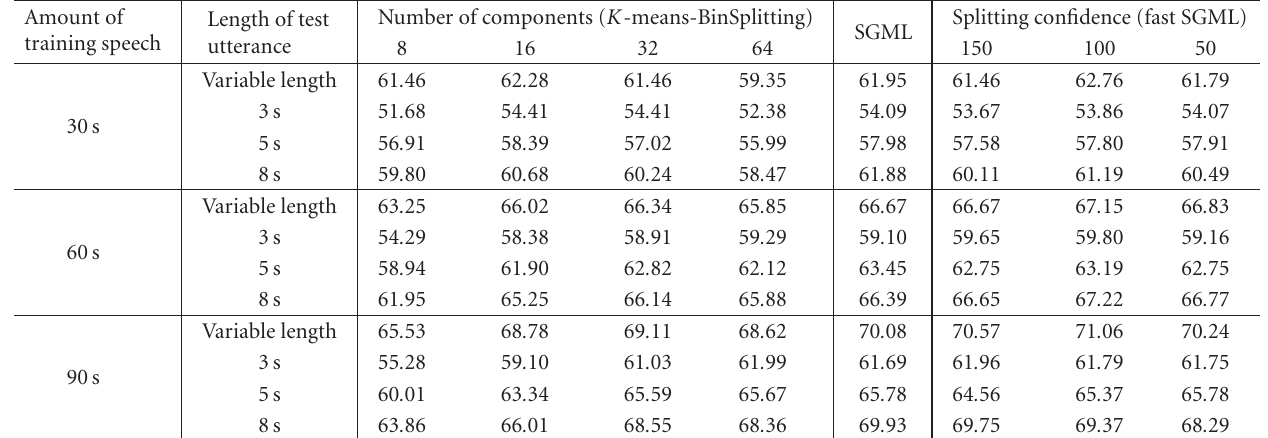
Table 3: Speaker identification accuracy (%) for the male speakers.